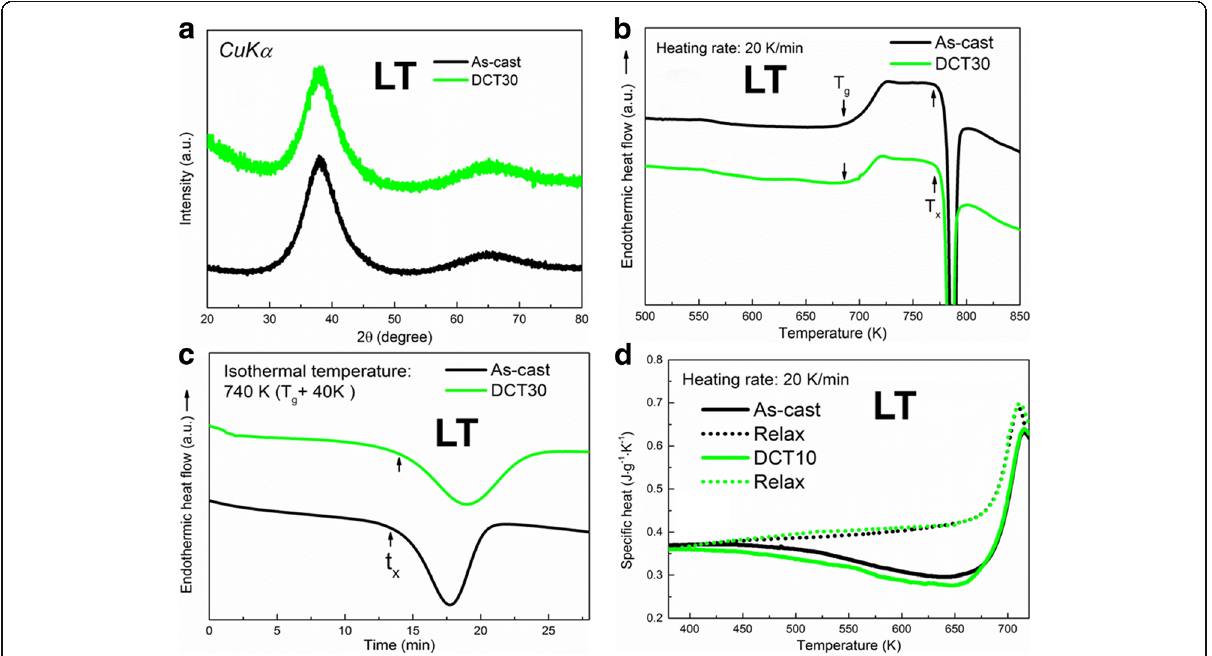
Fig. 3 a XRD and b DSC curves of both As-cast and DCT30 samples cast at LT. c Heat-flow as a function of time during isothermal annealing (740 K) and d specific heat of both As-cast and DCT30 samples cast at